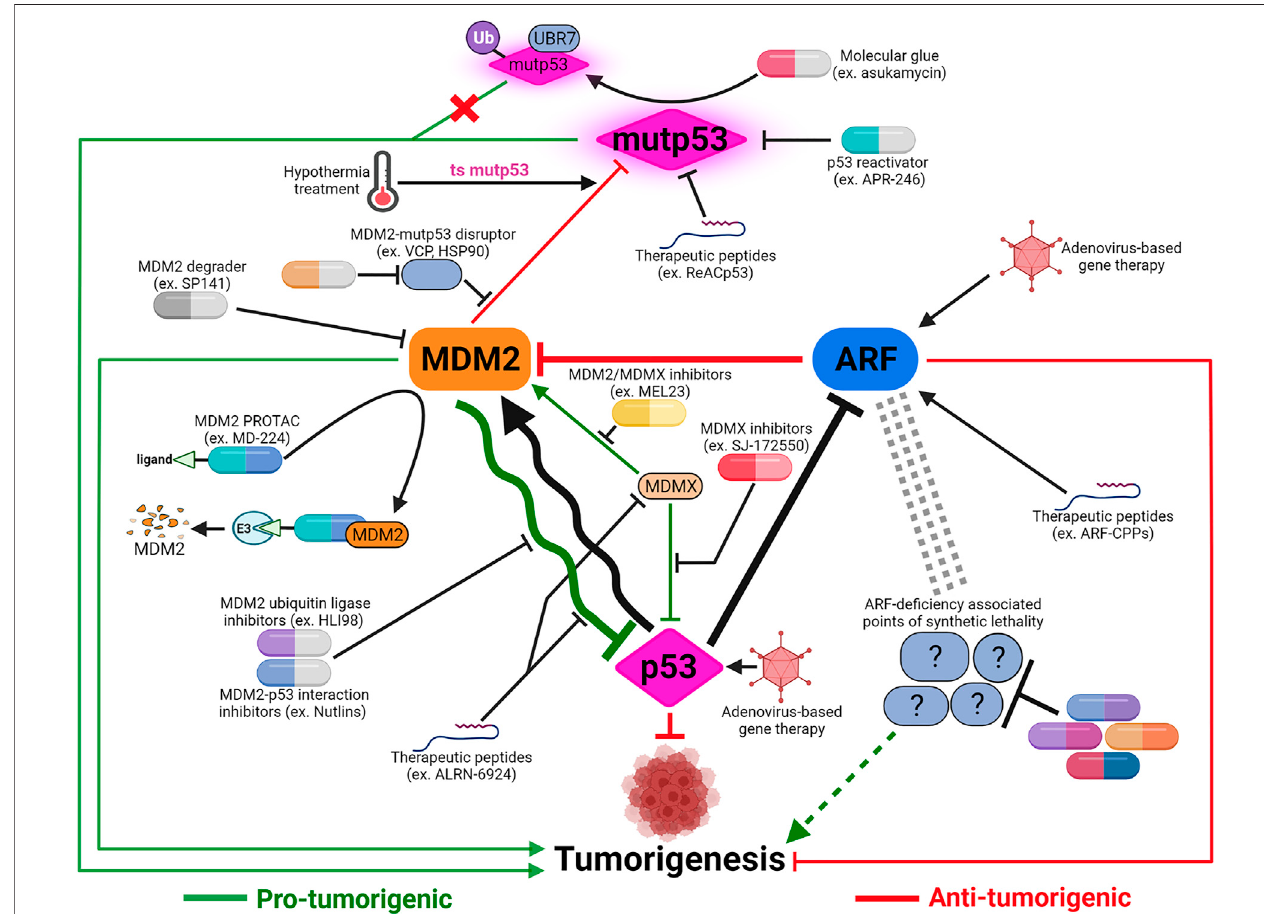
FIGURE4| Cancertherapeuticstrategiestargetingthep53-MDM2-ARFsignalingaxis.Themajorityofp53-basedtherapeuticstrategiesaredesignedtoreactivate mutant p53 or inhibit MDM2-p53 and MDM2/MDMX-p53 interactions using small molecules. Development of alternative strategies, such as applying hypothermal therapy to induce MDM2-mediated degradation of temperature-sensitive mutp53, or utilizing pan-MDM2 inhibitors, are meant to maximize anti-tumor potency depending on the context of MDM2-p53 relationship. In addition to small molecules, other modalities including therapeutic peptides and proteolysis targeting chimera (PROTAC) are also being explored to target both MDM2 ’ s p53-dependent and -independent functions. The realization of ARF ’ s many p53-independent functions and the functional signi fi cance of p53-ARF co-inactivation in cancers necessitates development of ARF-based therapies. Virus-mediated gene therapy and therapeuticpeptidesarepotentialwaystorestoreARFfunctions.Identi fi cationofsyntheticlethalityassociatedwithARFde fi ciencycanuncovernoveltherapeutictargets to compensate for ARF loss and potentially synergize with p53-targeting treatments. Created with BioRender.com.